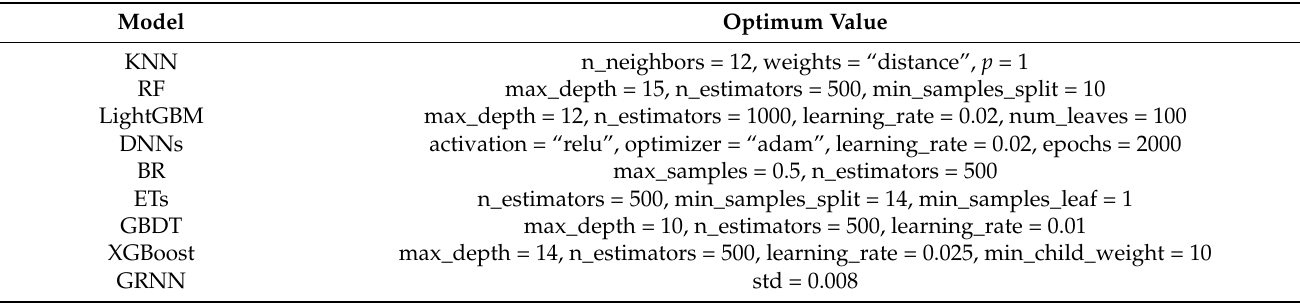
Table 2. Optimum values of the